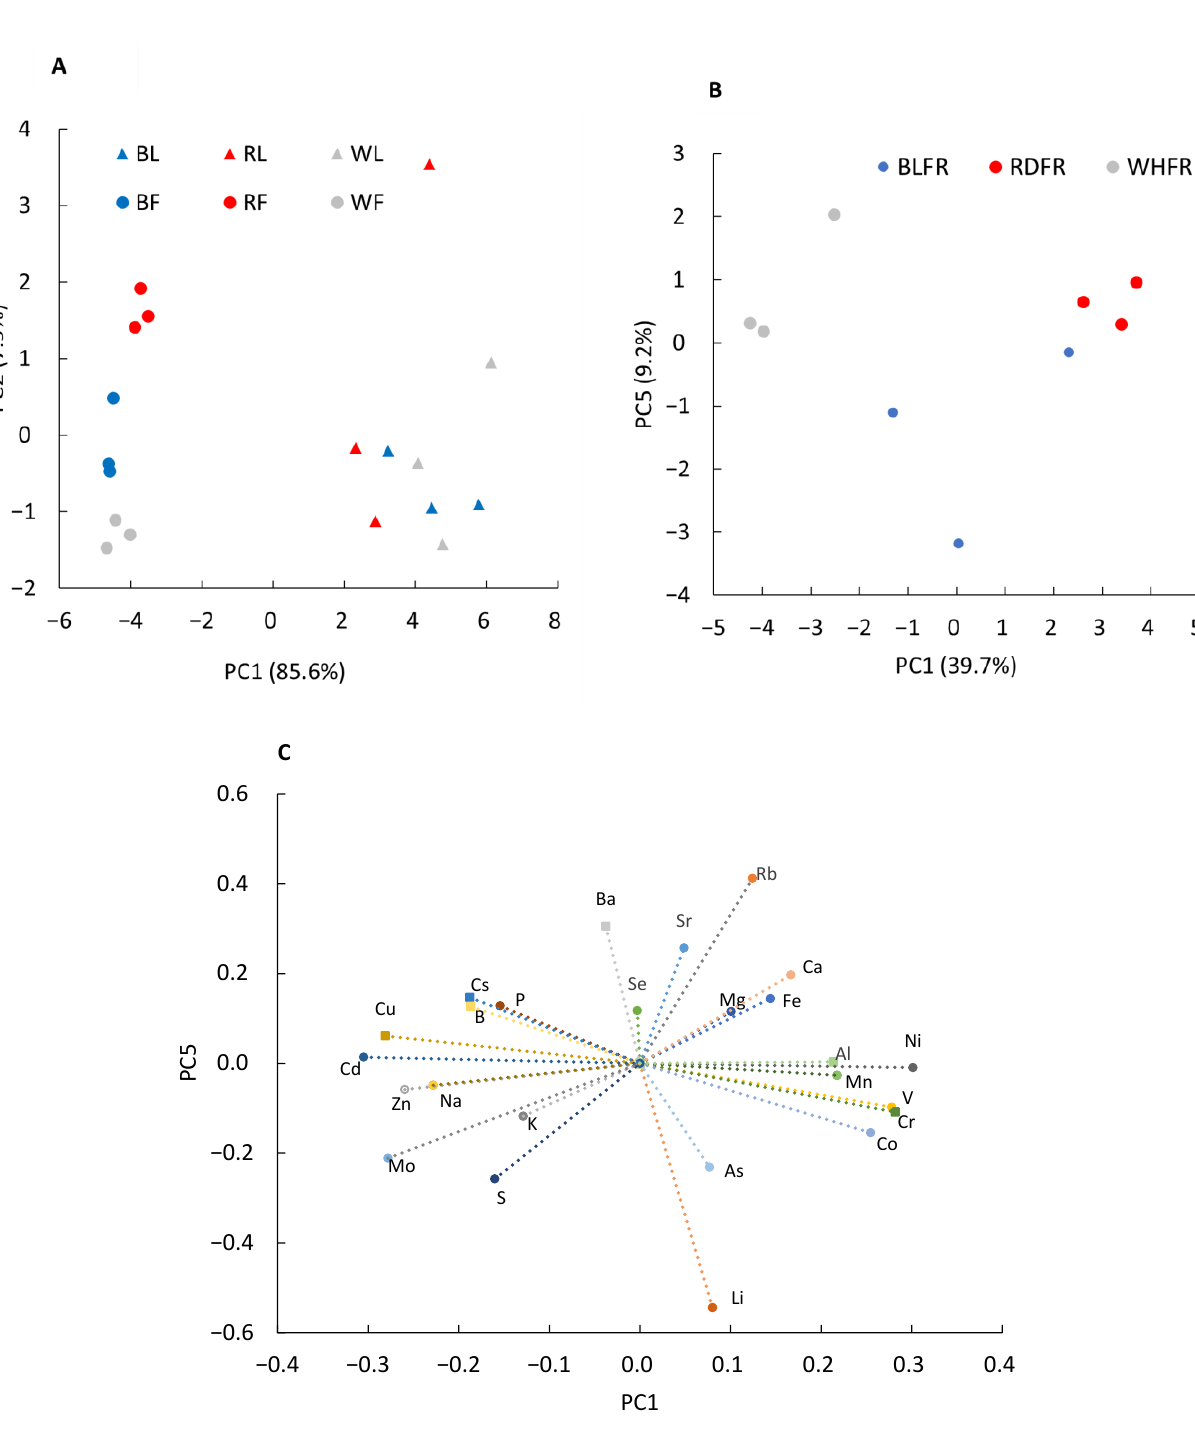
Figure 6. PCA of element concentration in leaves and fruits ( A ). BL and BF, blue-light-treated leaves and fruits; RL and RF, red light-treated leaves and fruits; WL and WF, white light-treated leaves and fruits. PCA ( B ) and factor loading ( C ) of element concentration in fruits. BLFR, RDFR, and WHFR refer to blue, red, and white light-treated fruits, respectively.